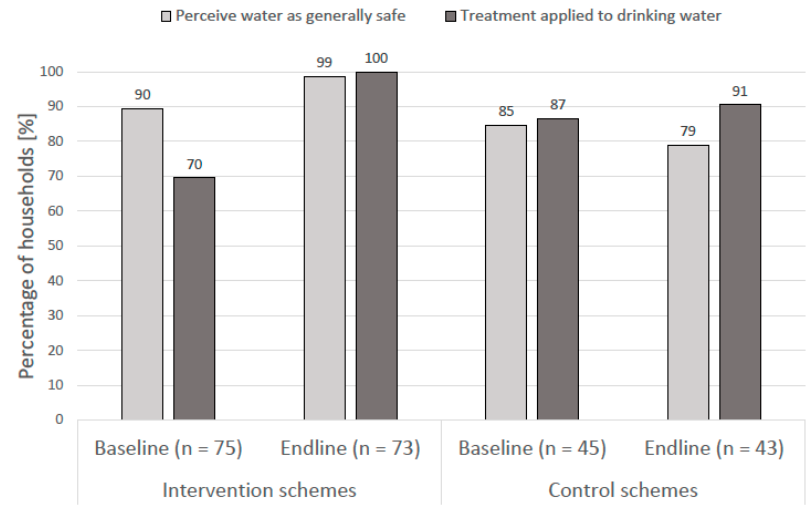
Figure 3. Drinking water safety perception and treatment coverage among the households served by the intervention and the control schemes from the baseline to the endline period.